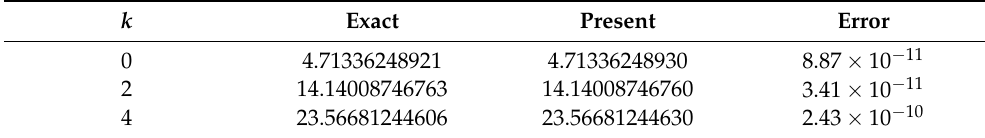
Table 6. Comparing the eigenvalues for Example 6 with the present BSFM to the exact ones and showing the